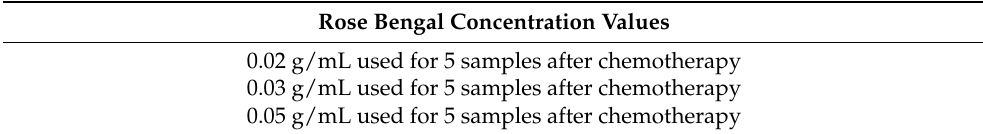
Table 1. Rose Bengal concentrations applied to breast cancer tissue samples. Rose Bengal Concentration Values 0.02 g/mL used for 5 samples after chemotherapy 0.03 g/mL used for 5 samples after chemotherapy 0.05 g/mL used for 5 samples after